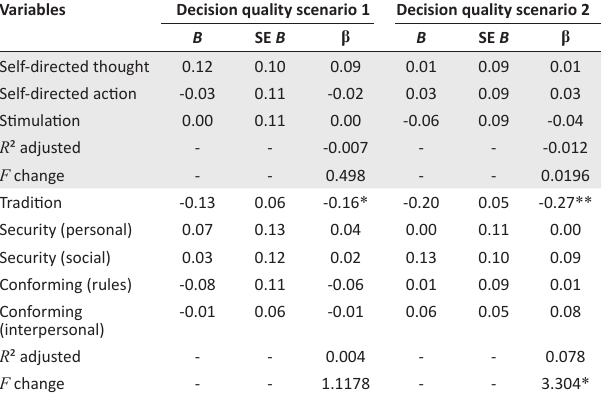
TABLE 3: Linear regression results for the values and decision quality.